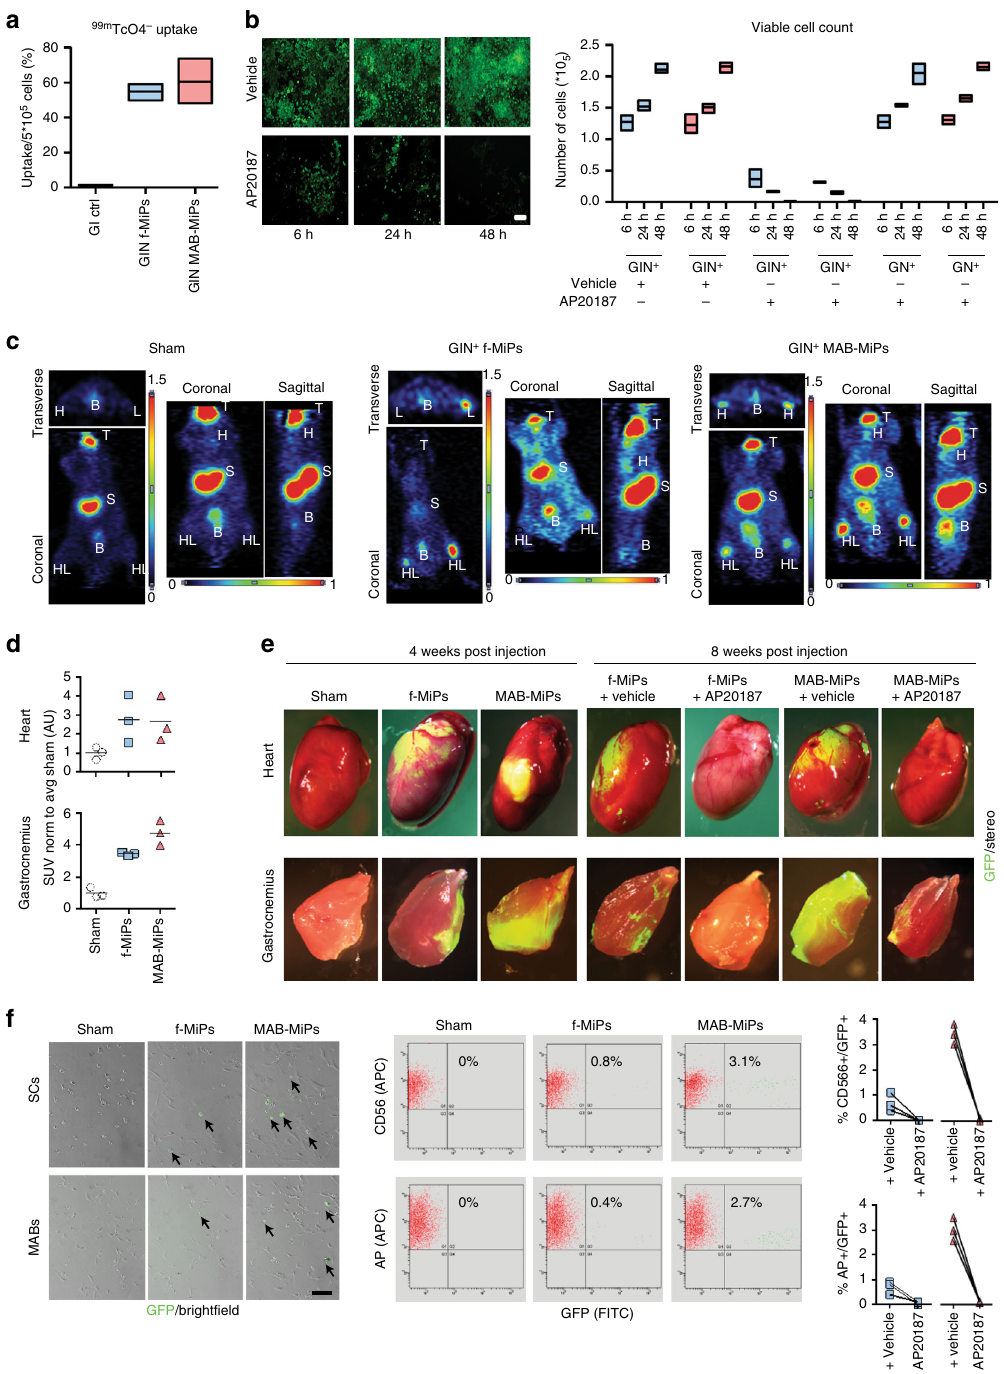
Fig. 1 Human MiPs display differential myogenic propensity in vivo. a Validation of NIS transgene functionality for PET imaging by quantitation of 99m TcO 4 − uptake in vitro. *Kruskal – Wallis test and Mann – Whitney U -test vs ctrl, P < 0.05, n = 3/cohort. Scale bar ∼ 100 µ m. b Validation of iCasp9 transgene by viable cell count after AP20187 administration in vitro. Only iCasp9+MiPs did signi fi cantly undergo progressive cell death, which appeared virtually complete after 48 h. *Two-way ANOVA with Bonferroni correction, P < 0.05 (interaction), n = 3/cohort. Data points depict average and min-to-max span for each sample. c 1 week after injection, PET scan of live animals shows engraftment of GIN+MiPs in heart (H) and hindlimbs (HL) muscles of only MiP-treated mice. T, thymus, S, stomach, B, bladder; endogenous positive PET signals. d SUV levels in heart and hindlimb regions of PET-scanned mice. * P < 0.05 vs sham; ** P < 0.05 vs sham and fi broblast-MiPs; Kruskal – Wallis and Mann – Whitney U test; n = 3/cohort. e Stereo fl uorescence analysis of heart and hindlimb ( gastrocnemius ) muscles of recipient mice before (4 weeks p.i.) and after (8 weeks p.i.) AP20187 administration. f Live fl uorescence and cytometry analyses of CD56-isolated SCs and AP-isolated MABs from recipient mice at end-point.both SCs and Mabs MAB-MiP-treated animals displayed larger GFP + subfractions than fi broblast-MiP-treated ones and GFP + cells were undetectable after AP20187 administration ** P < 0.05 vs fi broblast-MiP- treated mice; Kruskal – Wallis and Mann – Whitney U test; n = 3/cohort at end-point, scale bar ∼ 100 µ